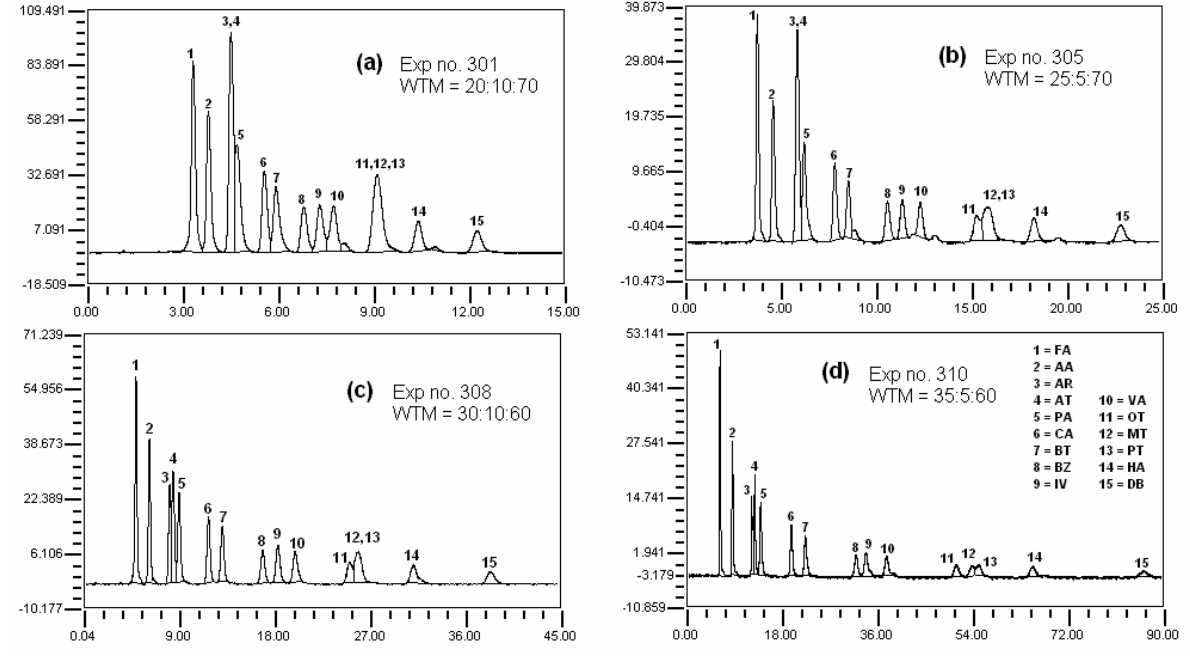
FIGURE 2 . Chromatogram of a mixture of 15 DNPH(o) derivatives (48 ng of CCs) in WTM ternary mobile